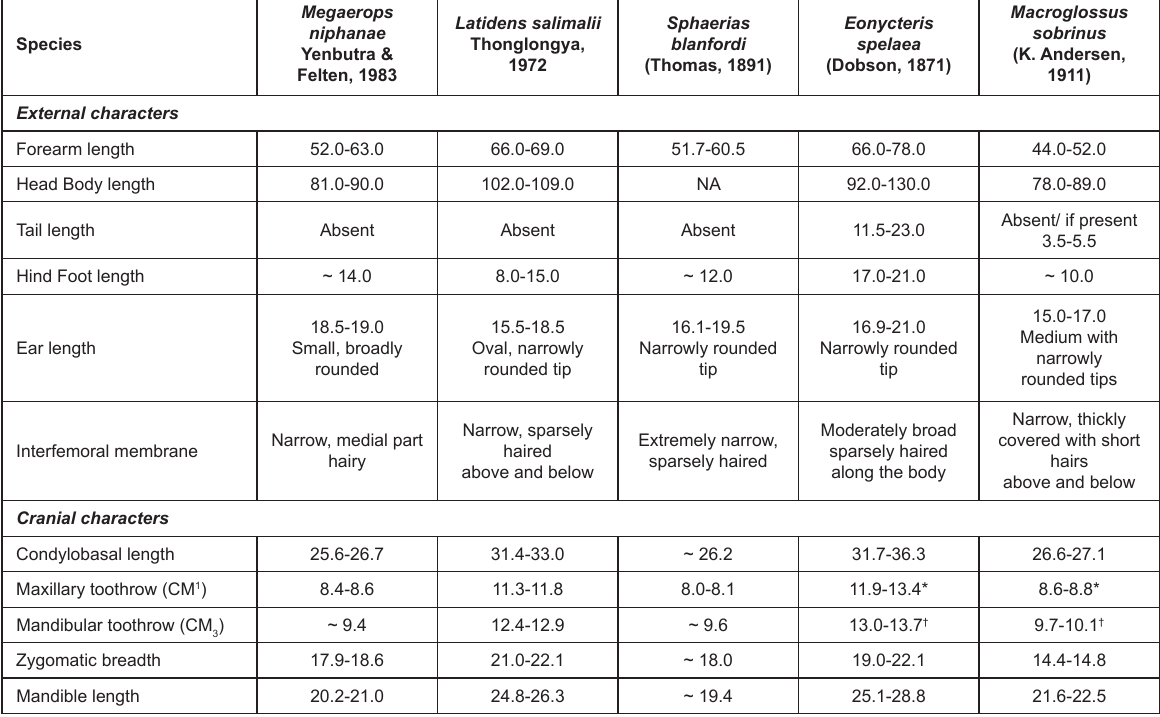
Note: All measurements are in mm; * – CM 2 ; † – CM